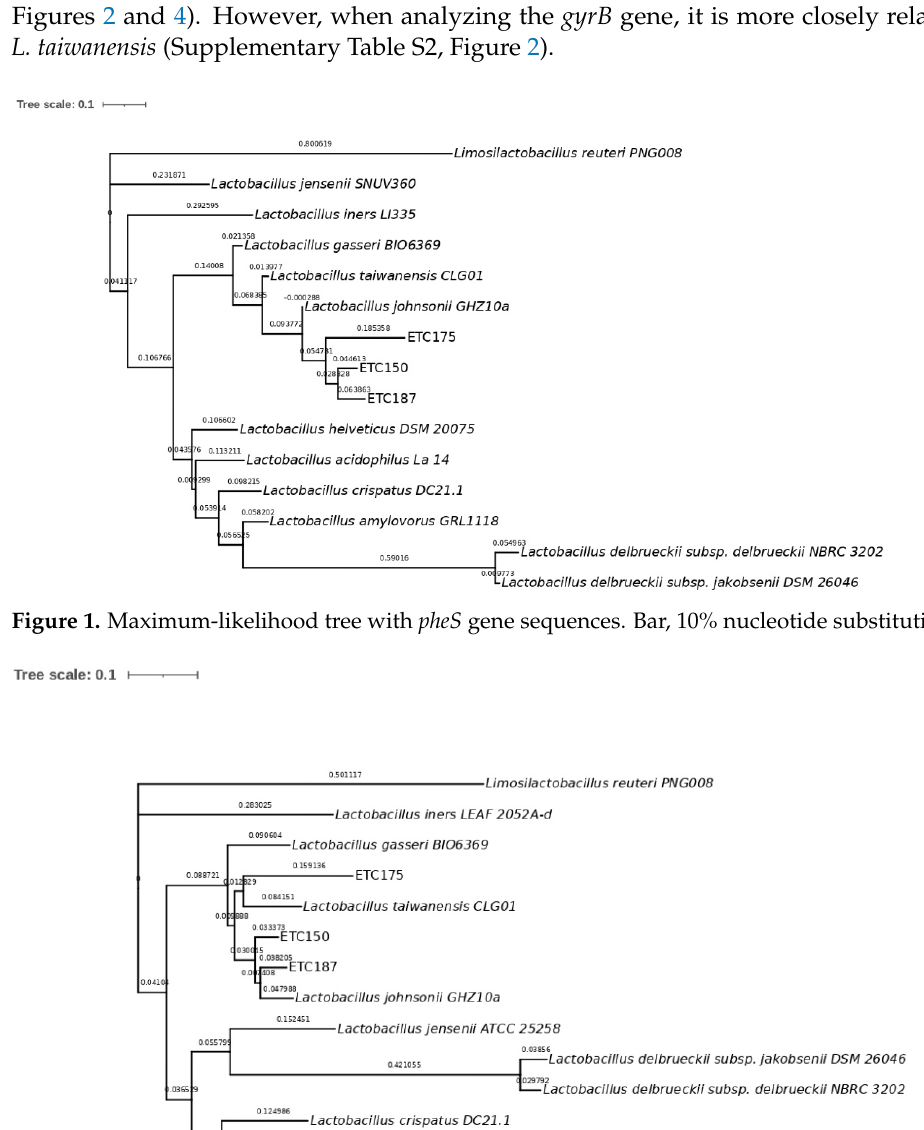
Figure 2. Maximum-likelihood tree with gyrB gene sequences. Bar, 10% nucleotide substitutions.